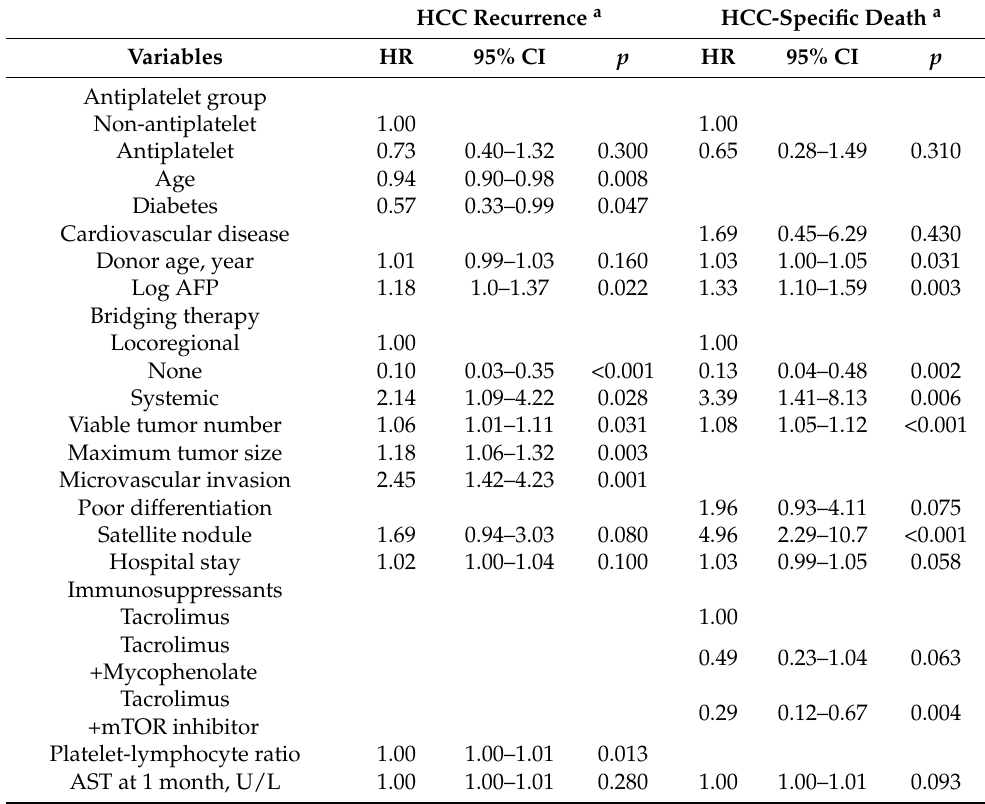
Table 2. Multivariable analyses for HCC recurrence and HCC-specific